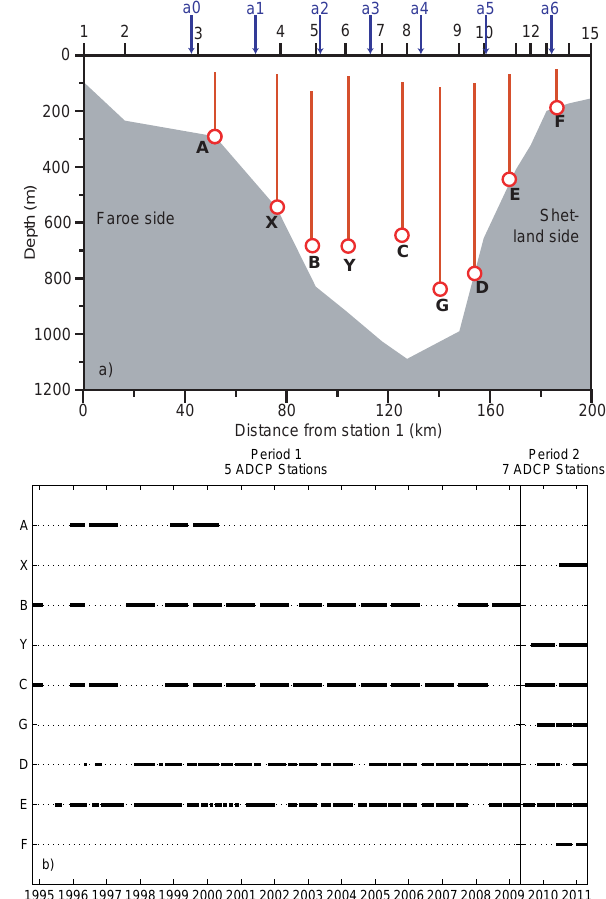
Fig. 3. (a) The observational cross section showing CTD stations 1 to 15 (black numbers) on the top axis and moored ADCPs as red circles with their typical range indicated by vertical red lines. Blue arrows show altimetry grid points a0 to a6. (b) Overview of months with valid deployments at all 9 ADCP sites across the